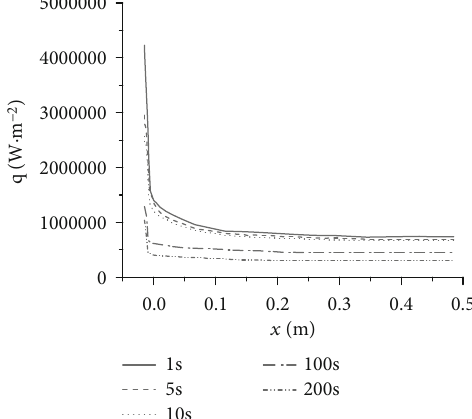
Figure 14: Heat fl ux along the nose cap wall.